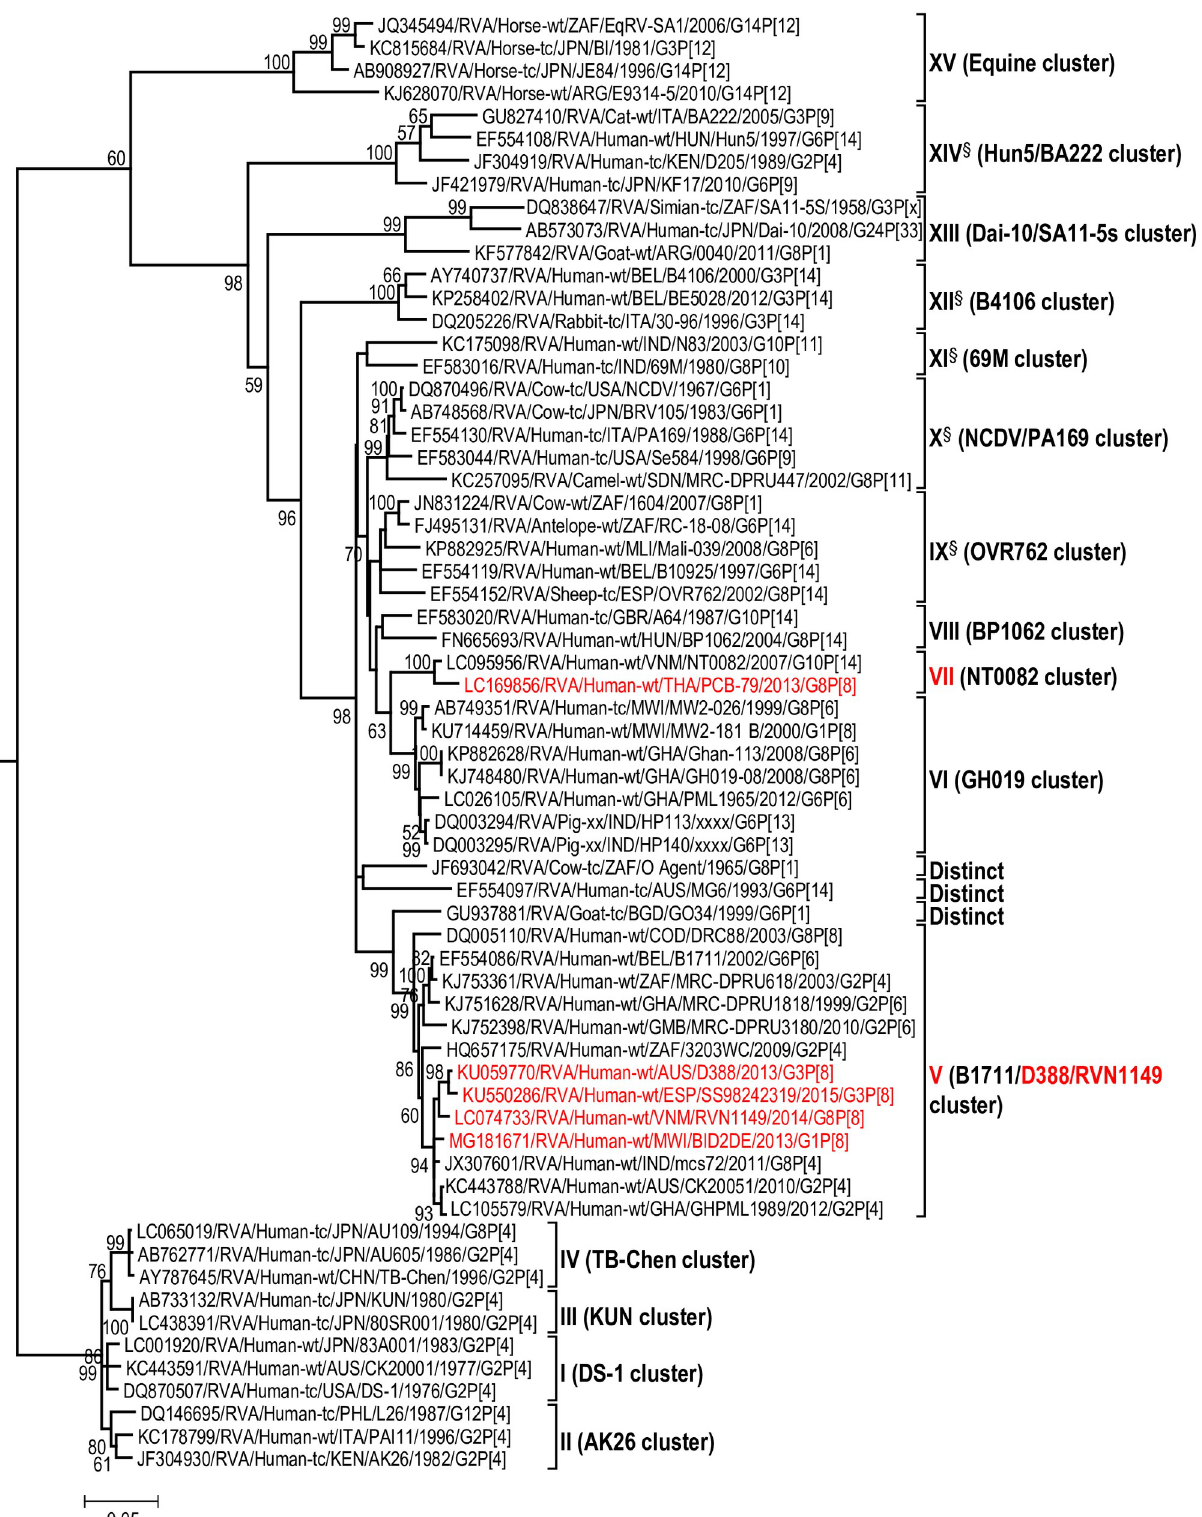
Fig 6. Reference phylogenetic lineage designation for the VP6-I2 genotype of RVA strains of human and animal host species origin. Phylogenetic tree was constructed using the maximum likelihood method with 1000 bootstrap replicate trials. The tree was rooted using the VP6-I1 gene of the genotype 1 prototype strain Wa. “Hybrid lineages” containing a mixture of human and animal RVA sequences are indicated with § in addition to the lineage number. Representative unusual emerging reassortant strains whose lineage constellations were determined in this study using the newly